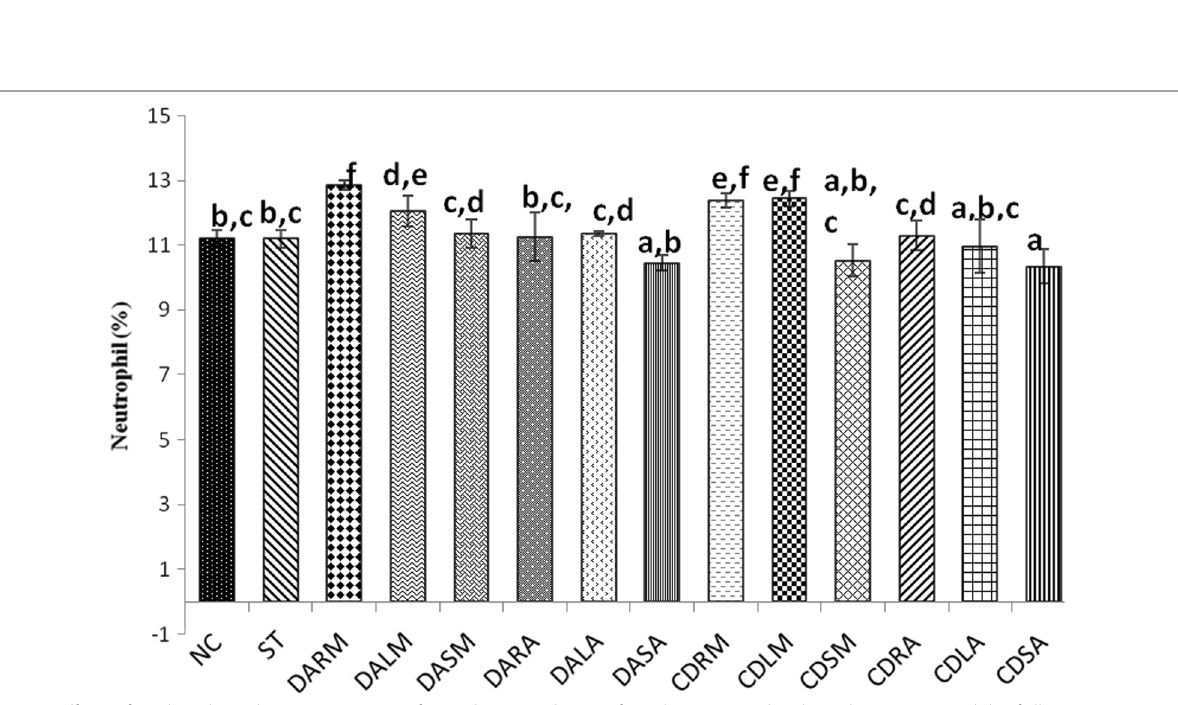
Fig. 6 Effects of methanolic and aqueous extracts of roots, leaves and stem of D. arborescens and C. dependens on Neutrophils of albino rats. Bars with similar alphabets are not statistically different ( p <